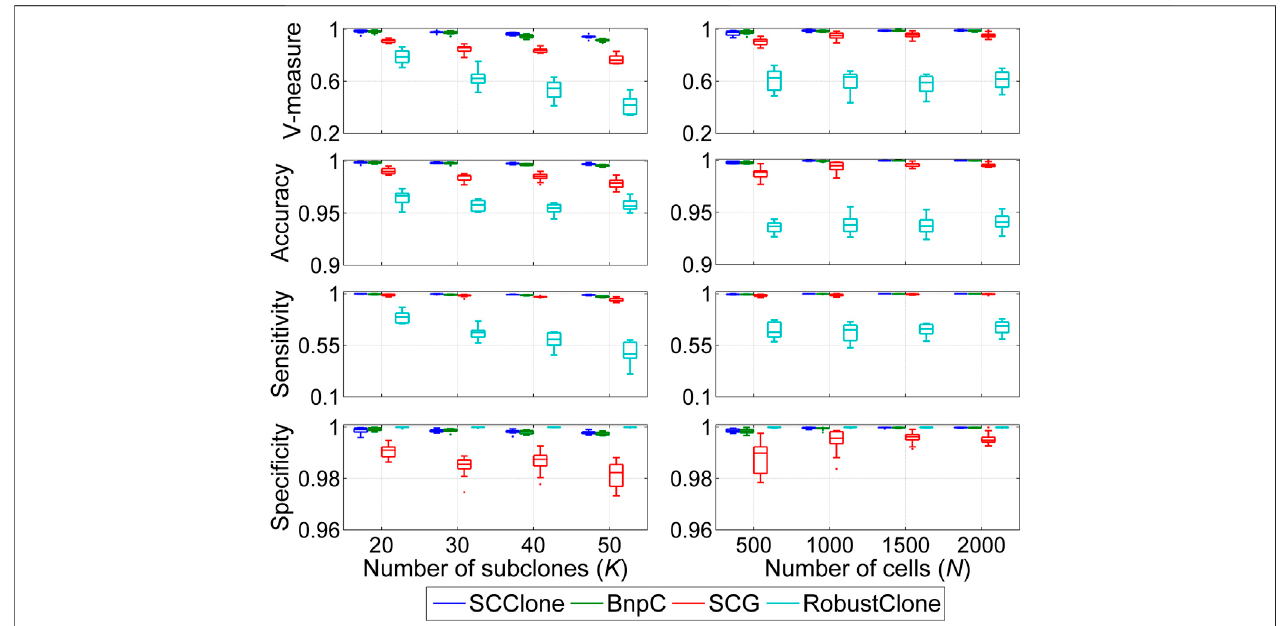
FIGURE 4 | Performance evaluation results on the simulated datasets D4 and D5. The dataset D4 consists of 1,000 × 500 genotype matrices with the number of subclones changing from 20 to 50, and dataset D5 is constituted by genotype matrices with the number of cells ranging from 500 to 2,000.